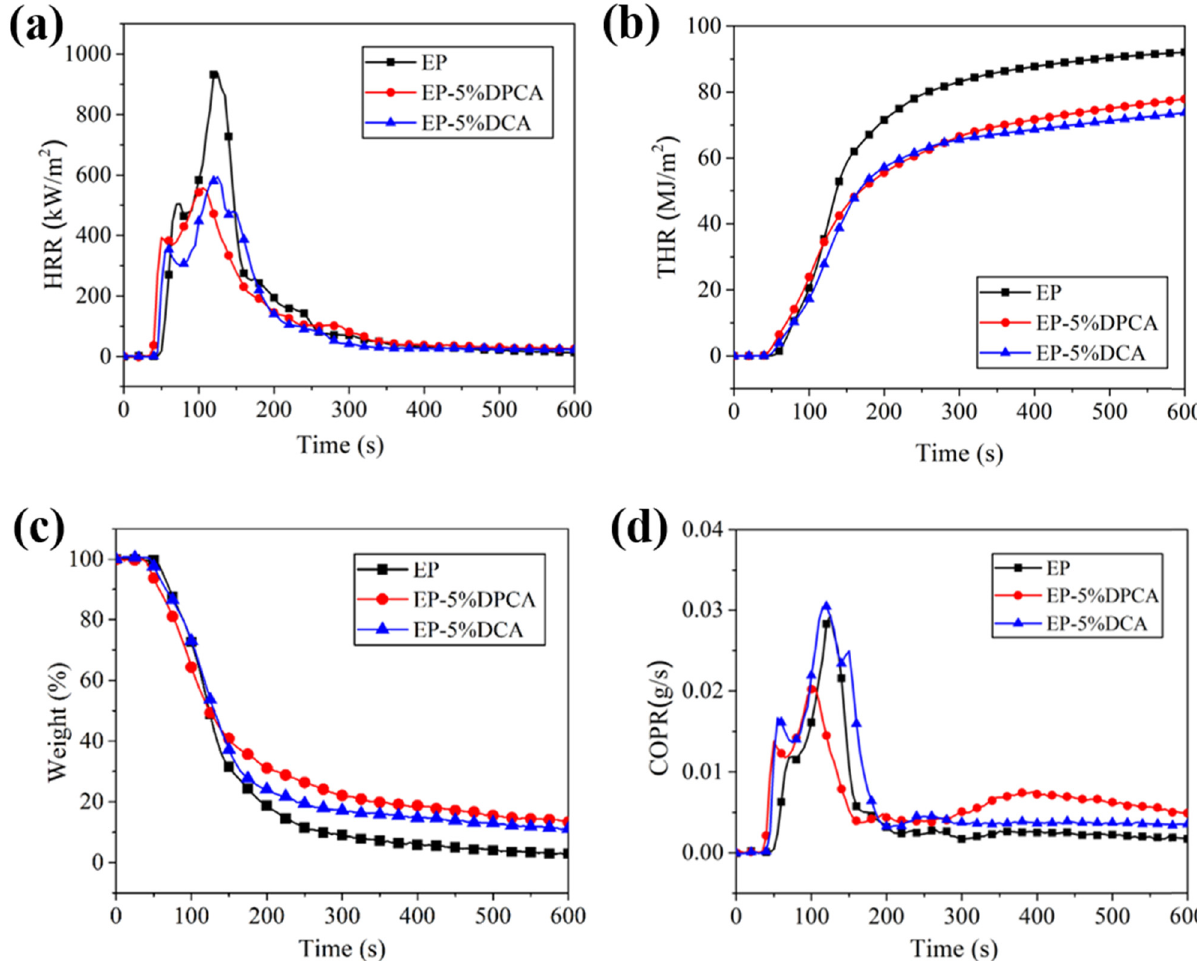
Figure 5: ( a ) HRR, ( b ) THR, ( c ) mass loss, and ( d ) COPR curves of EP, EP - 5 wt% DPCA, and EP - 5 wt%